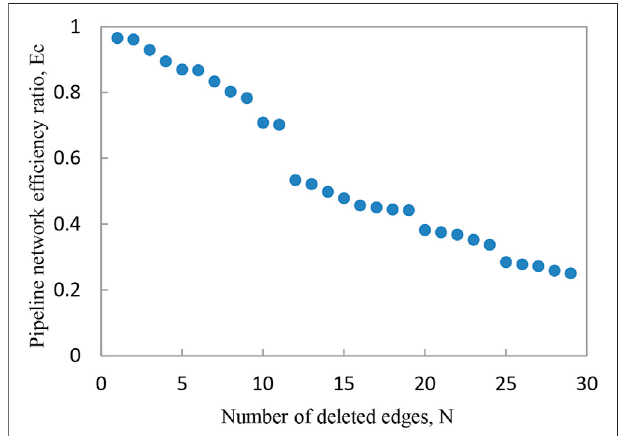
FIGURE 11 | The diagram of pipeline network ef fi ciency ratio.